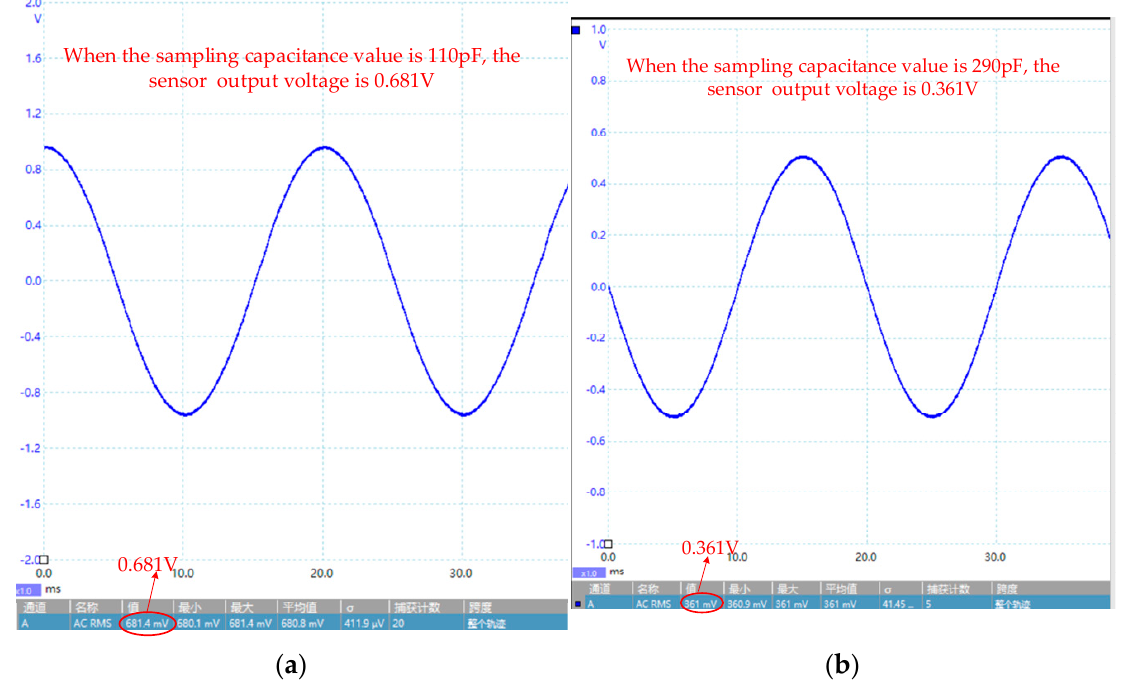
Figure 13. Varying the sampling capacitance value, the sensor outputs different voltages. ( a ) The sampled capacitance value is 110 pF; ( b ) the sampled capacitance value is 290 pF. Table 1. The output of the sensor after paralleling di ff erent capacitors and the calculated 𝐶 (cid:3051) value.